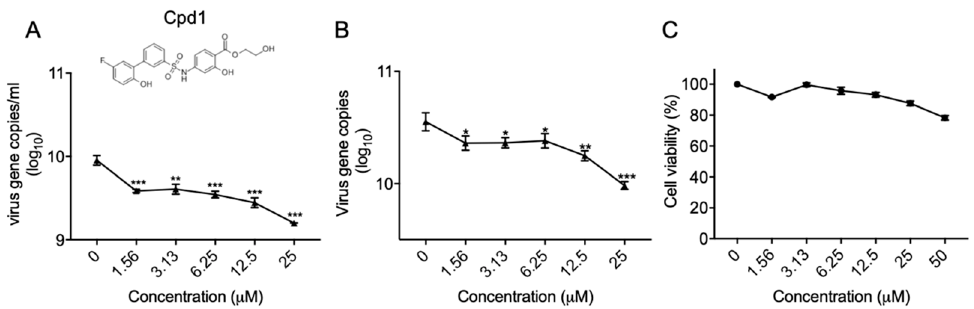
Figure 3. Anti-EV-A71 activity of compound 1 (Cpd1) in hNPCs. The ( A ) cell culture supernatant and ( B ) cell lysate of the virus-infected cells (MOI = 1.0, 48 hpi) were collected for RNA extraction and qRT-PCR detection. ( C ) MTT assay showing the cell viability of hNPCs with different concentrations of Cpd1 treatment for 48 h without virus infection. All the experiments were performed in triplicate. Error bars represent SEM. * denotes p < 0.05, ** denotes p < 0.01 and *** denotes p < 0.001. One-way ANOVA when compared with the 0 μ M group (0.05% dimethyl sulfoxide (DMSO)).